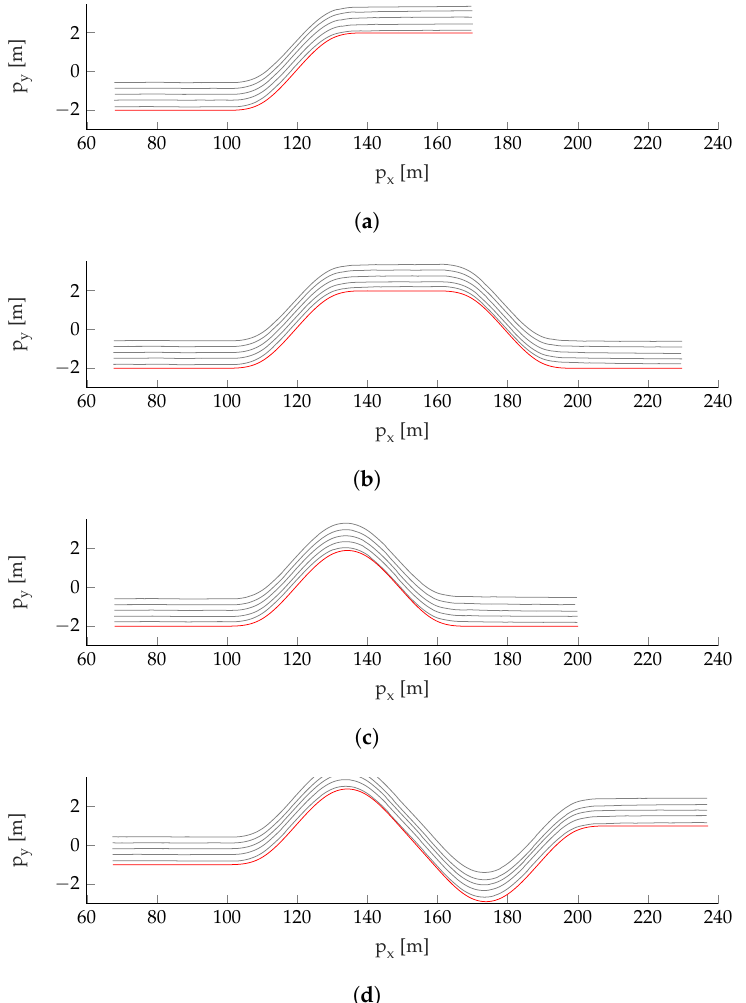
Figure 3. The planned trajectory (red) and the driving data (gray, shifted by multiples of 30 cm in p y for presentation purposes) for the maneuvers. ( a ) Single lane-change maneuver. ( b ) Double lane-change maneuver. ( c ) Fast double lane-change maneuver. ( d ) Slalom